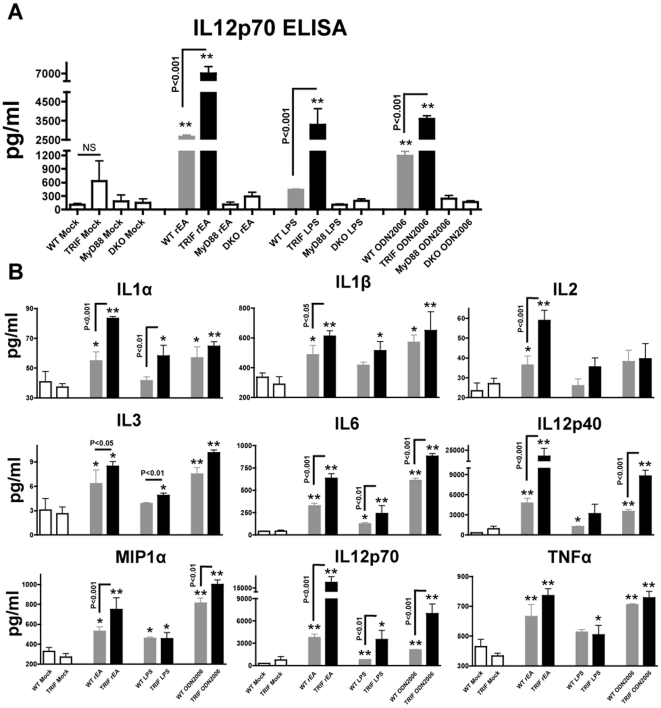
TRIF negatively regulates cytokine production by DCs, triggered by several common TLR agonists.(A) CD11c+ dendritic cells were isolated from C57BL/6 WT (N = 3), MyD88-KO (N = 3), TRIF-KO (N = 3), and MyD88/TRIF-DKO (N = 3) mice, in vitro stimulated with various TLR agonists, and used to perform a IL12p70 ELISA as described in Materials and Methods. The bars represent Mean ± SEM. Statistical analysis was completed using a one-way ANOVA with Student-Newman-Keuls post-hoc test. ** - Indicate values that are statistically different from those in unstimulated DCs (for the same genotype), p<0.001. No significant differences between mock-injected animals of different genotypes were detected. No significant activation of IL12p70 was observed in MyD88-KO and MyD88/TRIF-DKO DCs. (B) DC culture media was collected at 15 hours post stimulation with various TLR agonists (rEA, LPS, ODN2006) and was analyzed for cytokines/chemokines levels using a multiplexed bead array based quantitative system. Statistical analysis was completed using a one-way ANOVA with a Student-Newman-Keuls post-hoc test. The bars represent Mean ± SD. *, ** - Indicate cytokine values that are statistically different from those in mock injected animals, p<0.05, p<0.001 respectively.